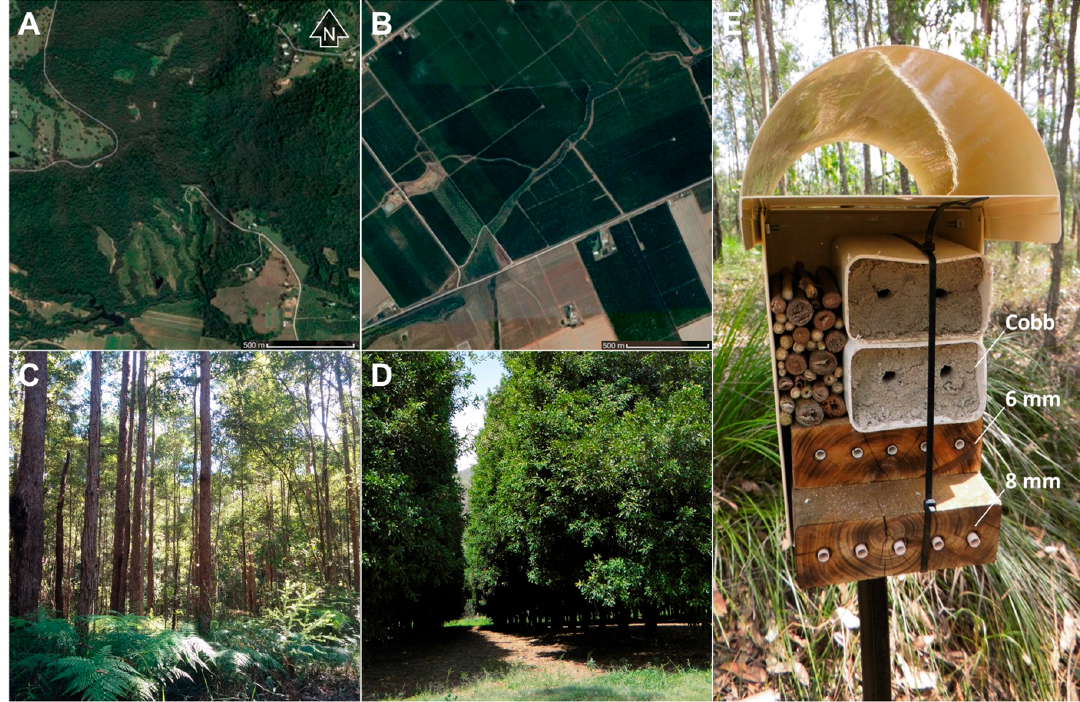
Figure 1. Study landscapes and trap nests. View of a forest ( A ) and orchard ( B ) landscape used in this study; habitat structure within a forest ( C ) and orchard ( D ) site; and an example of the trap nest units deployed in all sites ( E ) with cob blocks, pithy stems, short timber (100 mm long × 6 mm diameter) and long timber (150 mm long × 8 mm diameter) trap nests.